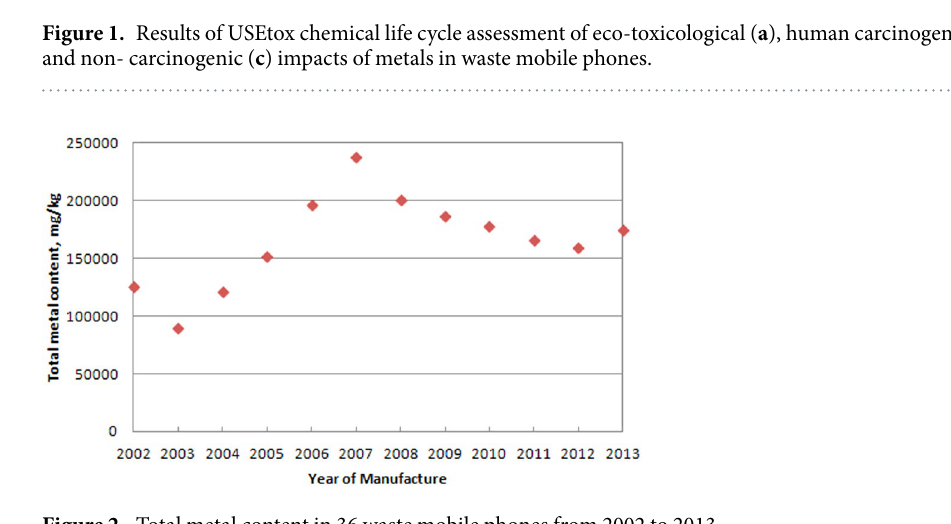
Figure 2. Total metal content in 36 waste mobile phones from 2002 to